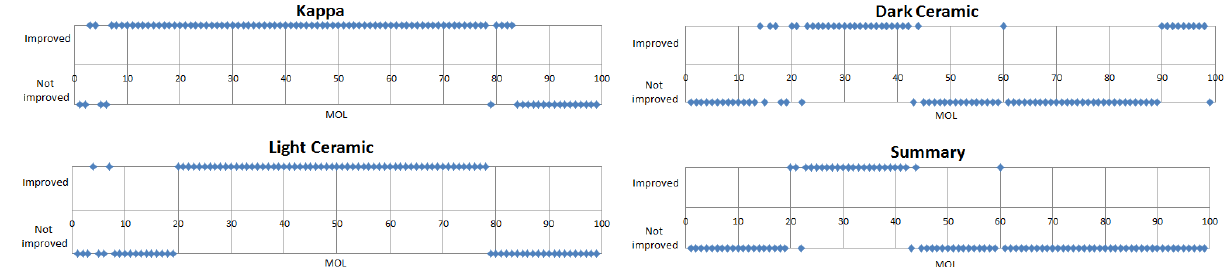
Figure 7. Classification performance × MOL according to t -test ( p -value=